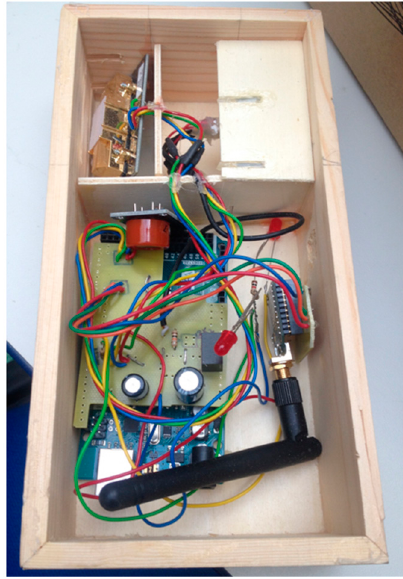
Figure 7. iAQ Sensor hardware.